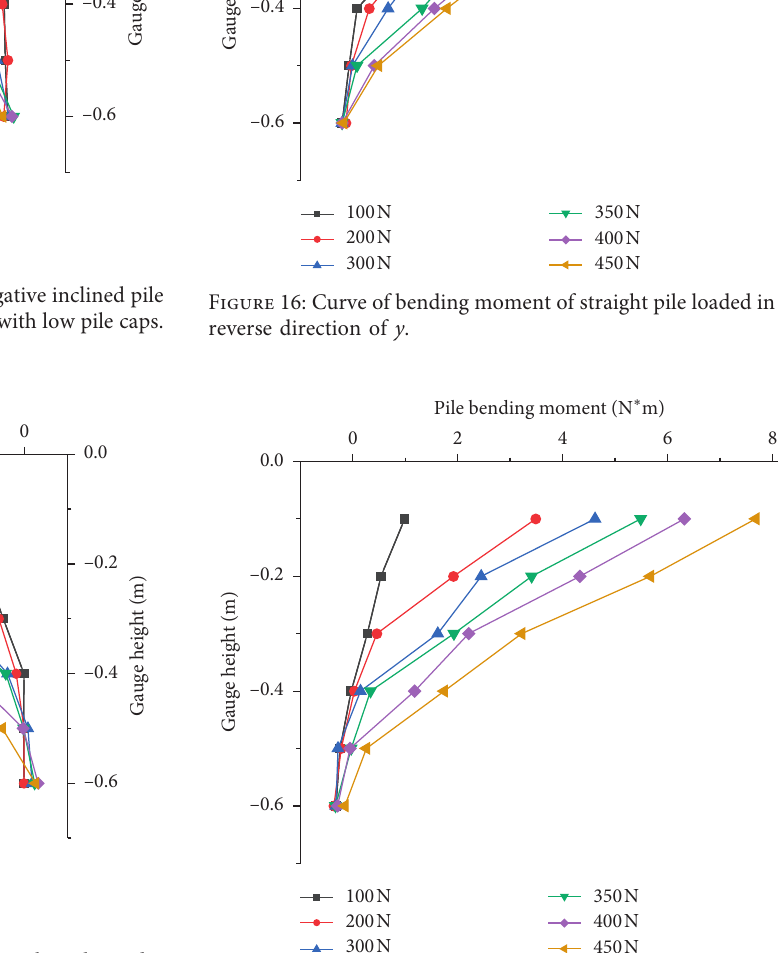
Figure 15: Bending moment curve of the straight pile under horizontal loading in y direction of two-layered soil pile groups with low pile caps.